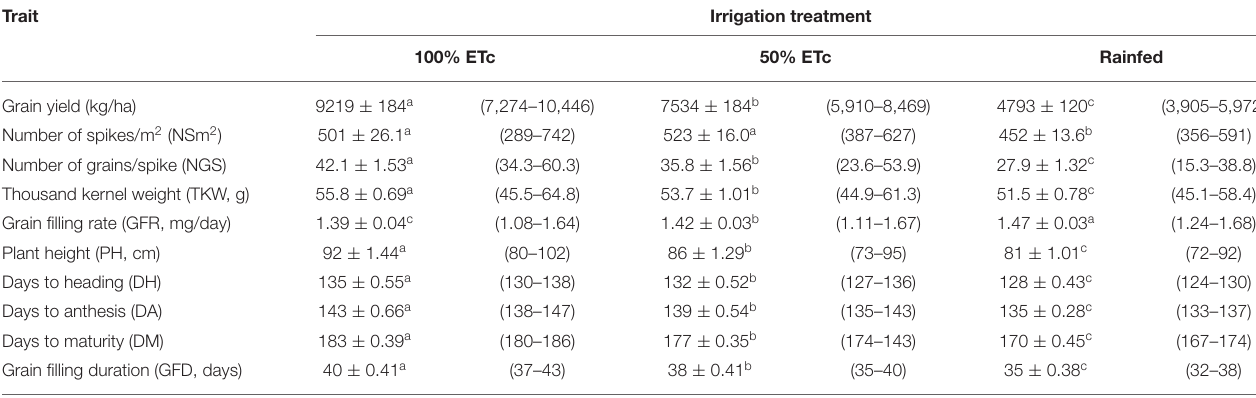
TABLE 1 | Mean values SE and ranges (between brackets) for yield and yield-related traits of the 19 durum wheat genotypes included in the study. ±